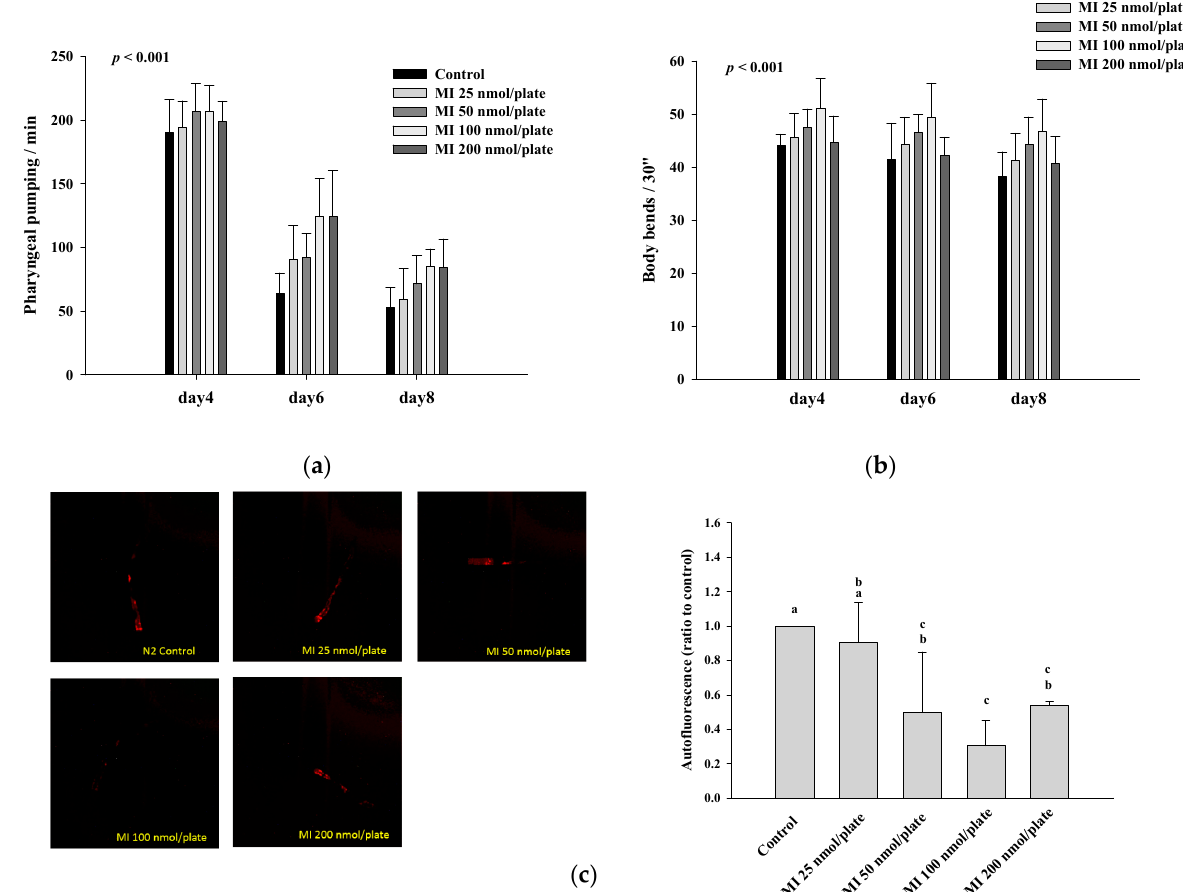
Figure 2. Effects of the myo-inositol (MI) on the pharyngeal pumping, body bends, and autofluorescence of wild-type C. elegans . The nematodes were grown on plates with different dosages of MI (0, 25, 50, 100, and 200 nmol/plate). On the fourth, sixth and eighth days, and the 10th day of life, ( a ) the pharyngeal pumping (n = 10), ( b ) body bends (n = 10), and ( c ) autofluorescence (left: photos; right: quantitative results, n = 3) were determined as described in Methods. For the results of pharyngeal pumping and body bends, the data were analyzed by the simple regression analysis method, but the data of 200 nmol/plate MI were excluded. p values are shown in the figures, or values (mean ± SD) not sharing a common letter are significantly different ( p < 0.05). The results are from a representative experiment out of two independent experiments.